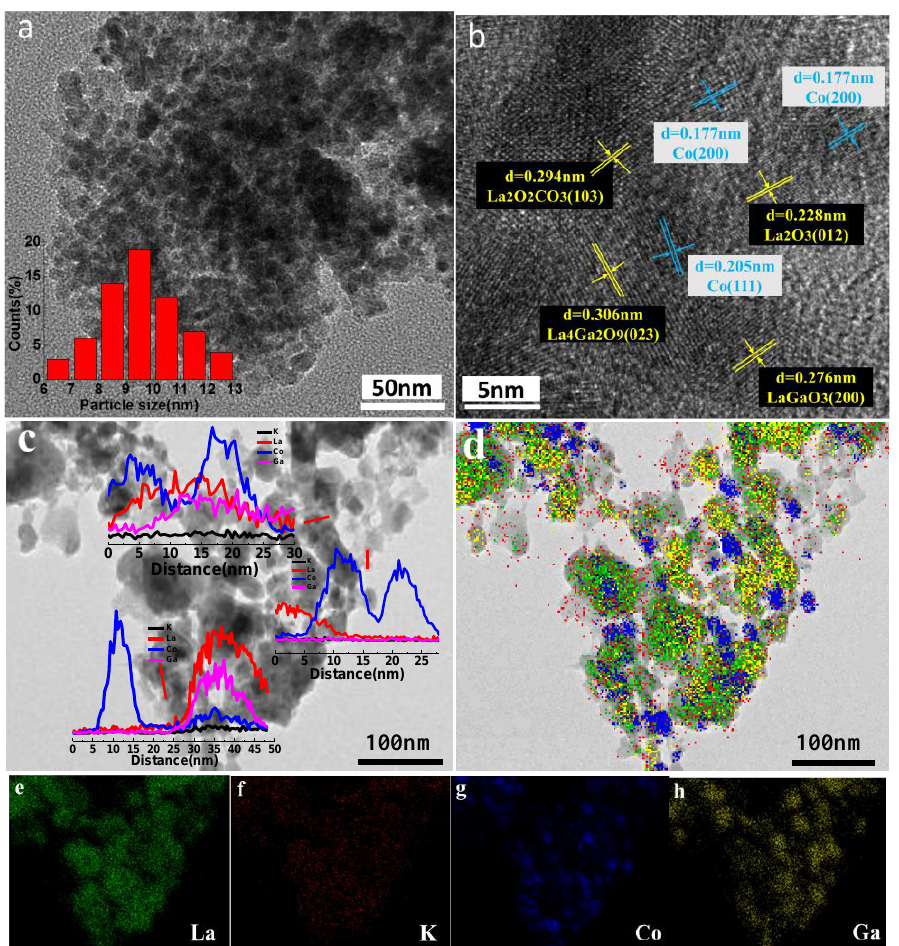
Figure 6. TEM images ( a – c ), line scanning profiles, EDS mapping image ( d ), and the elements distribution of La ( e ), K ( f ), Co ( g ), and Ga ( h ) for LKCG-0.1 after 200 h stability tests. Table 4. CO hydrogenation performance of the investigated